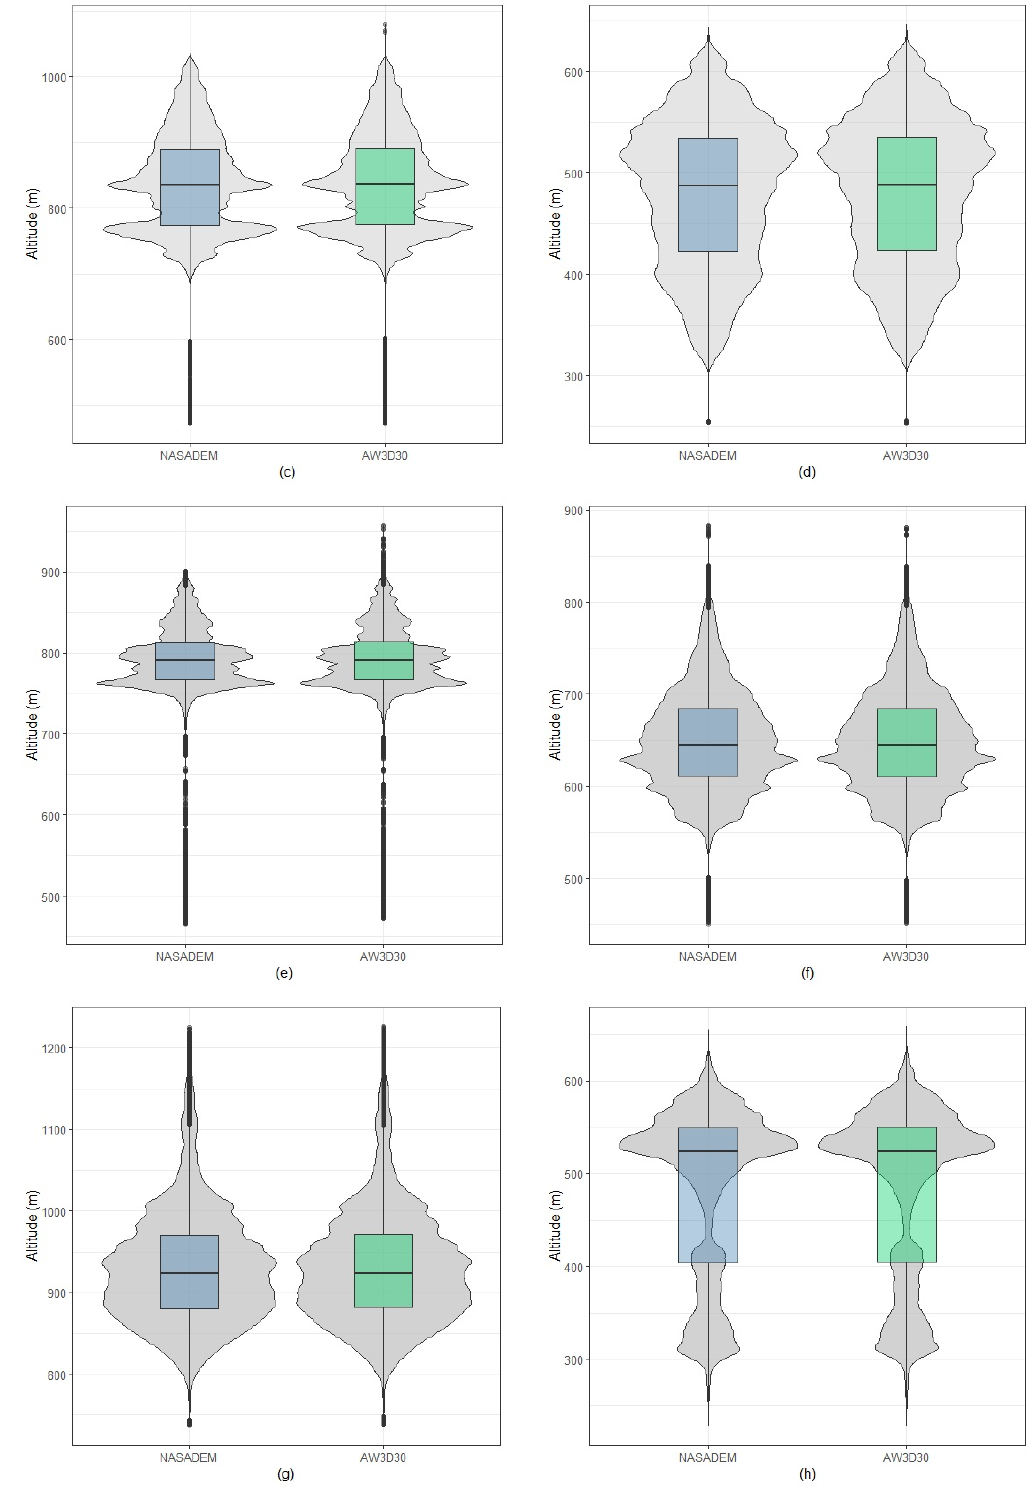
Figure 9. Violin plots of the NASADEM_HGT and AW3D30 digital elevation models for the agricultural areas of Sapezal ( a ), Rio Verde ( b ), São Desidério ( c ), Maracaju ( d ), Formosa do Rio Preto ( e ), Primavera do Leste ( f ), Cristalina ( g ), and Balsas ( h ) municipalities.